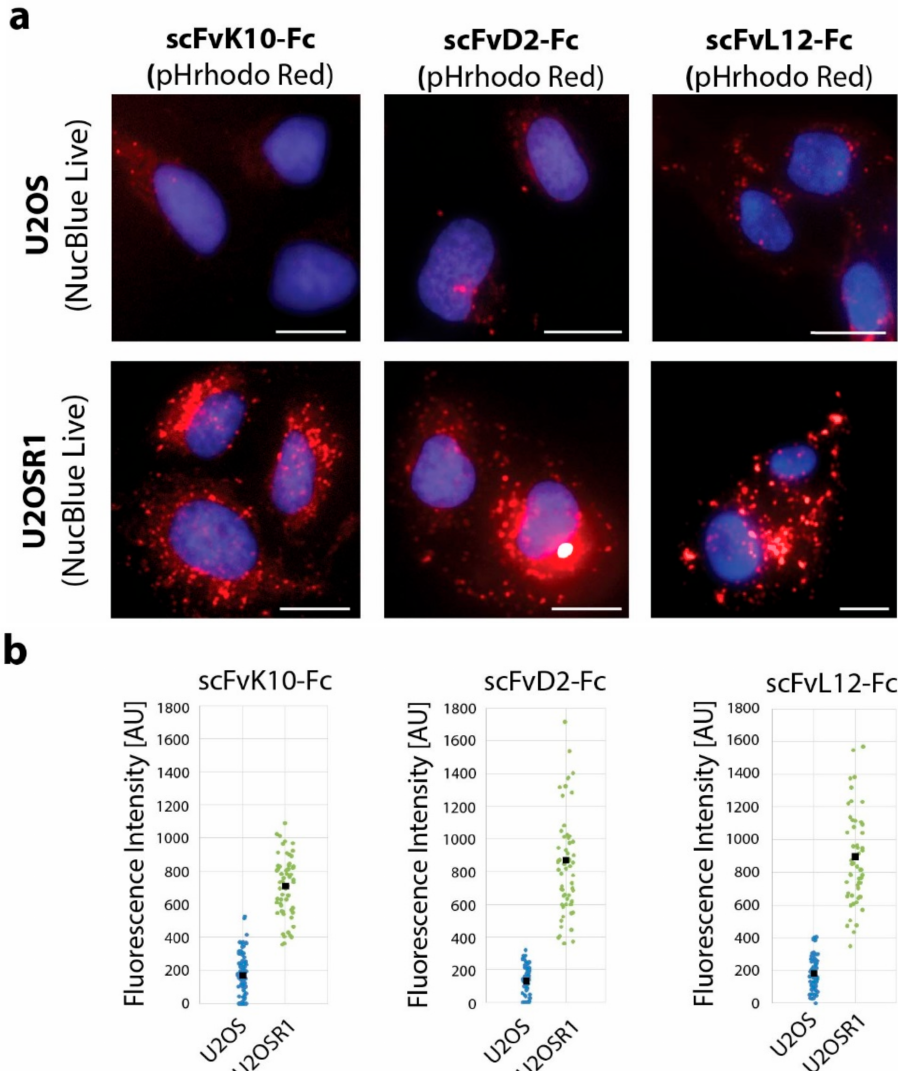
Figure 3. FGFR1-dependence of scFv proteins internalization. ( a ) U2OS (control) and U2OSR1 cells (overproducing FGFR1) were incubated for 2 h with pHrodo Red labeled scFv proteins (red). Nuclei were stained with NucBlue Live (blue) and cells were analyzed by fluorescence microscopy. Scale bars represent 20 µ m. ( b ) Quantification of internalization of pHrodo Red-labeled scFvs into U2OS and U2OSR1 cells. pHrodo Red fluorescence intensity inside single cells was measured using Zen 2.3 software (Zeiss, Oberkochen, Germany). At least 30 cells were measured from five fields of view for U2OS and U2OSR1 cells. Each square on the graph represents fluorescence intensity of single cell. Black squares represent average fluorescence intensity for particular cell